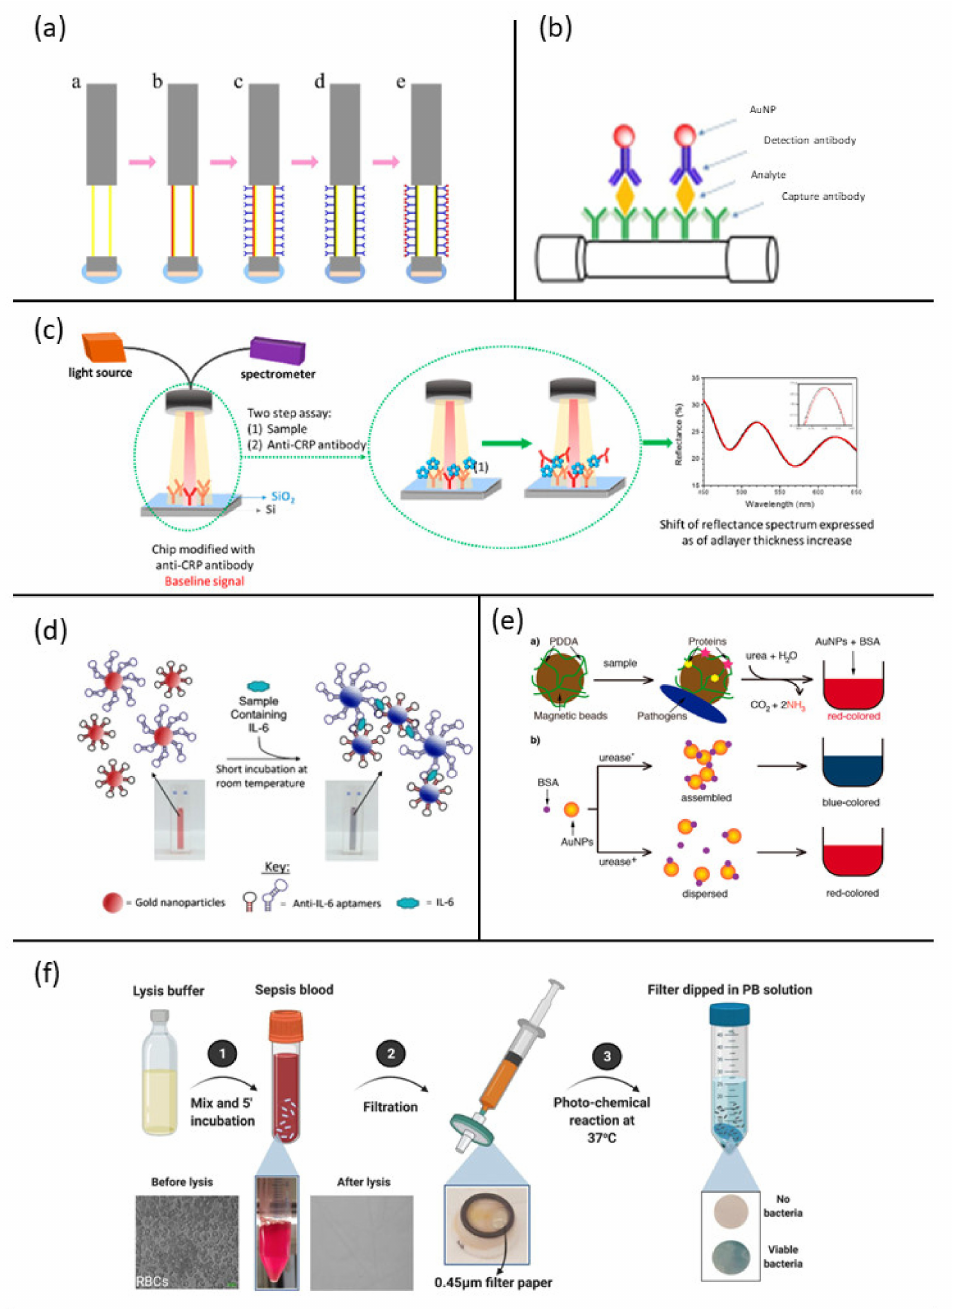
Figure 5. Examples of optical biosensor approaches for sepsis diagnosis: ( a ) steps for fabrication of the fiber optic SPR biosensor fort the CRP detection, reprinted with permission of [89] Creative common CC BY 4.0; ( b ) schematic sandwich assay for PCT detection, reprinted with permission of [90] Copyright 2019 Elsevier B.V.; ( c ) schematic sensing principle for CRP detection, reprinted from [97] Creative common CC BY 4.0; ( d ) schematic of the aptamer-gold nanoparticle-based assay for the detection of mouse IL-6, reprinted from [91] Creative common CC BY 4.0; ( e ) schematic representation of the method for detect urease positive bacteria involved in sepsis, reprinted with permission of [93], Copyright © 2019, American Chemical Society; ( f ) schematic showing the working principle of selective isolation and detection of bacteria from whole blood involved in sepsis, reprinted [95], Creative common CC BY